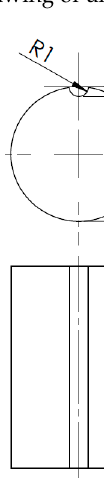
Figure 12. Drawing of the notched cylinder.